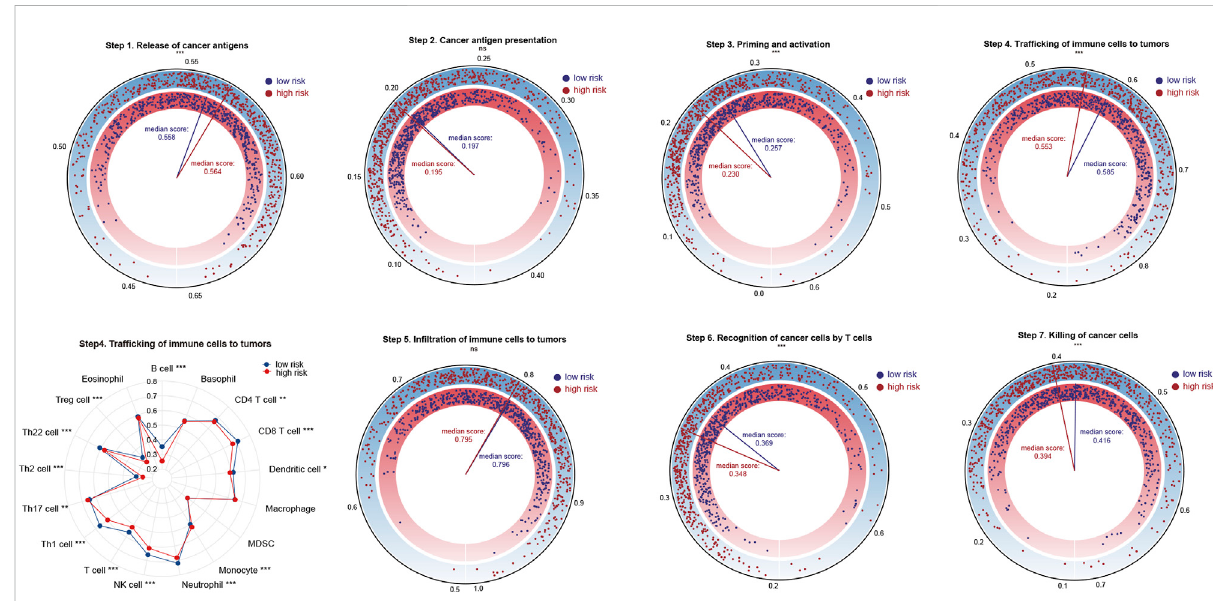
FIGURE 6 Analysis of theactivation statusof seven-step anti-cancer immunitycycle for highand low riskpatients. StatisticalSigni fi cance: * p < 0.05; ** p < 0.01; *** p < 0.001; ns, not signi fi